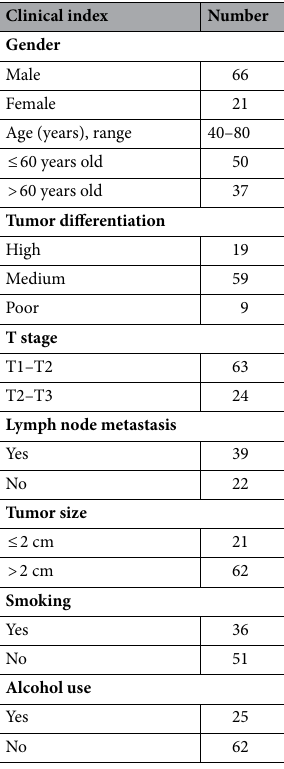
Table 4. Laryngeal cancer specimen information. Of the 87 cases of laryngeal cancer, 26 did not feature lymph nodes metastasis, whereas the tumor size could not be determined in 4